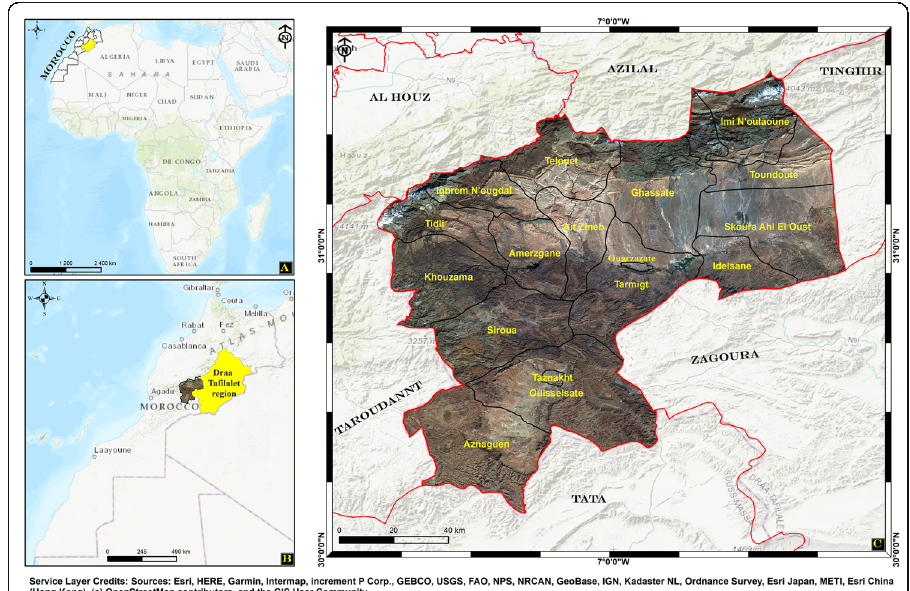
Fig. 1 Location of the study area. A African view. B National view. C Regional view of